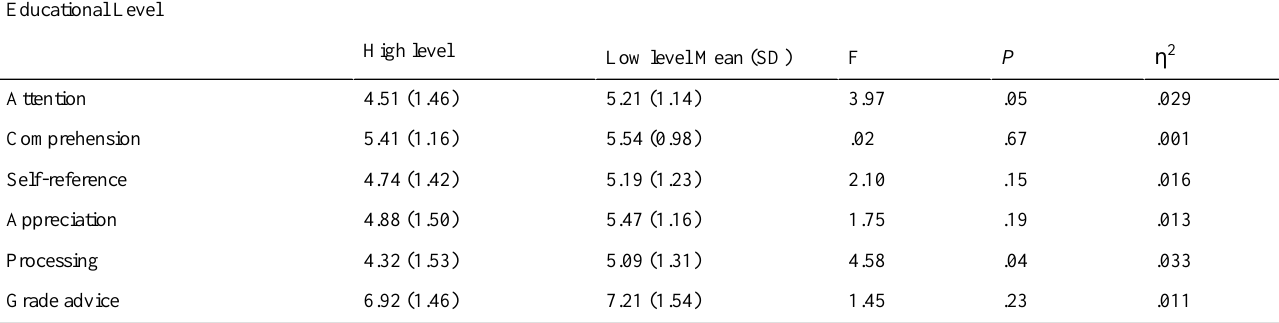
Table 4. Differences in variances of socioeconomic status with regard to message-processing mechanisms (N=139). Educational Level